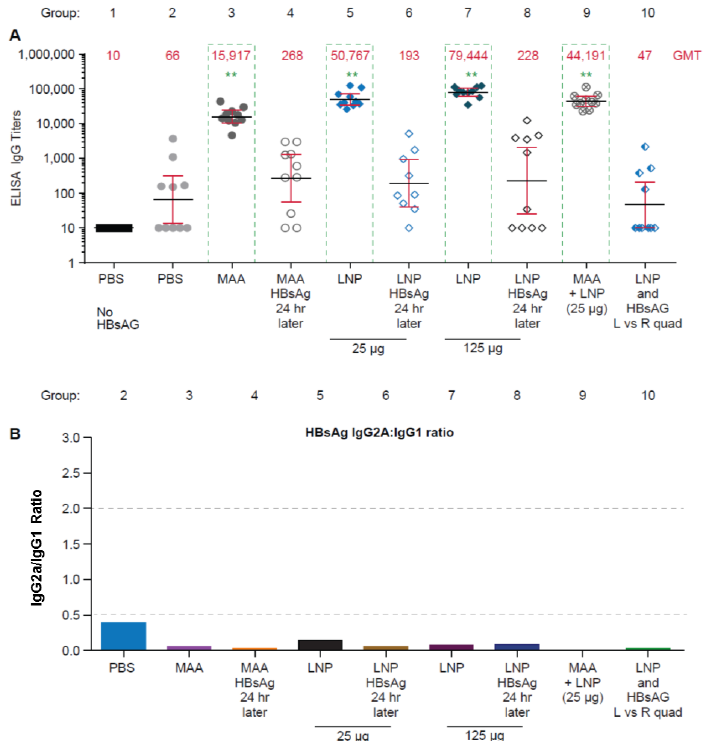
Figure 2. HBsAg-specific immunoglobulin (Ig)G responses in BALB/c mice. Lipid nanoparticles must be co-administered with HBsAg to enhance Th2 type specific B-cell responses in BALB/c mice. ( A